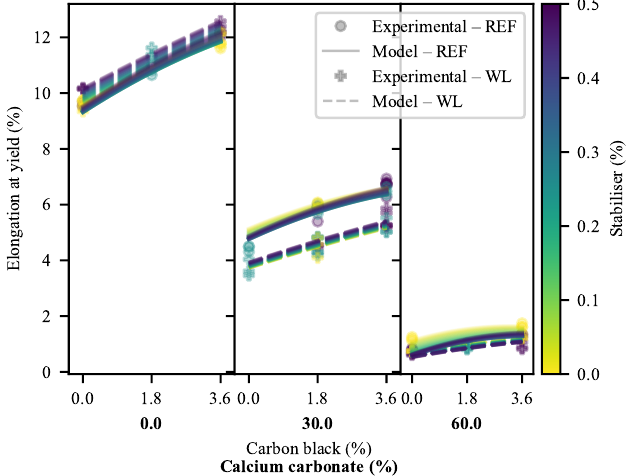
where DC is the deviation contribution and DF is the deviation contribution factor.